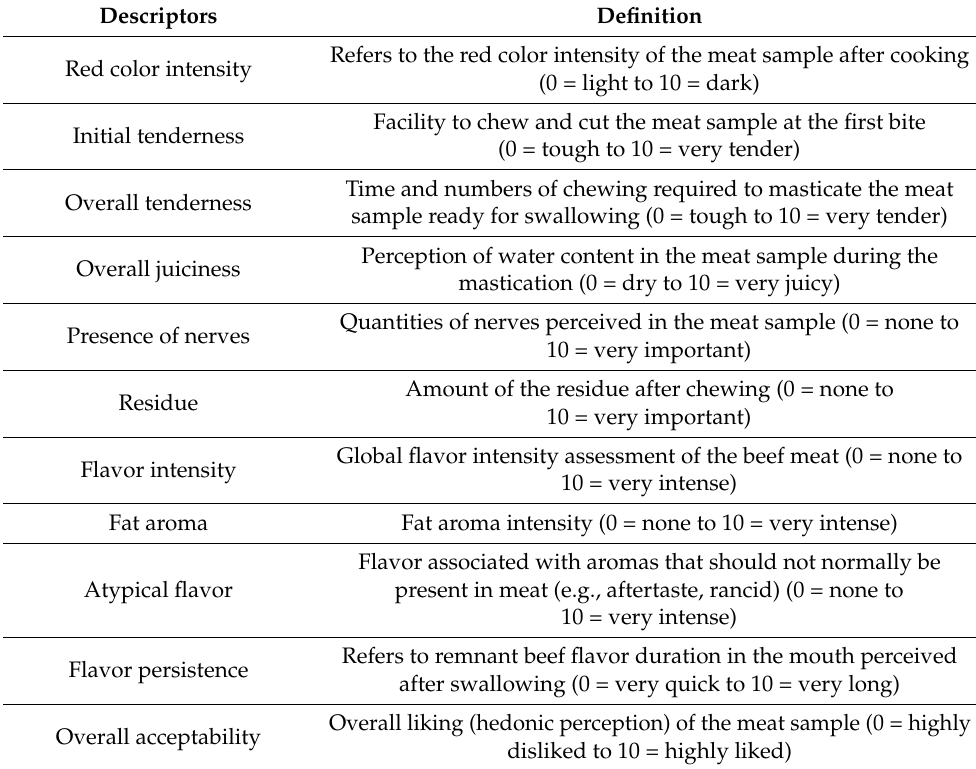
Table 2. Definitions of the sensory and hedonic